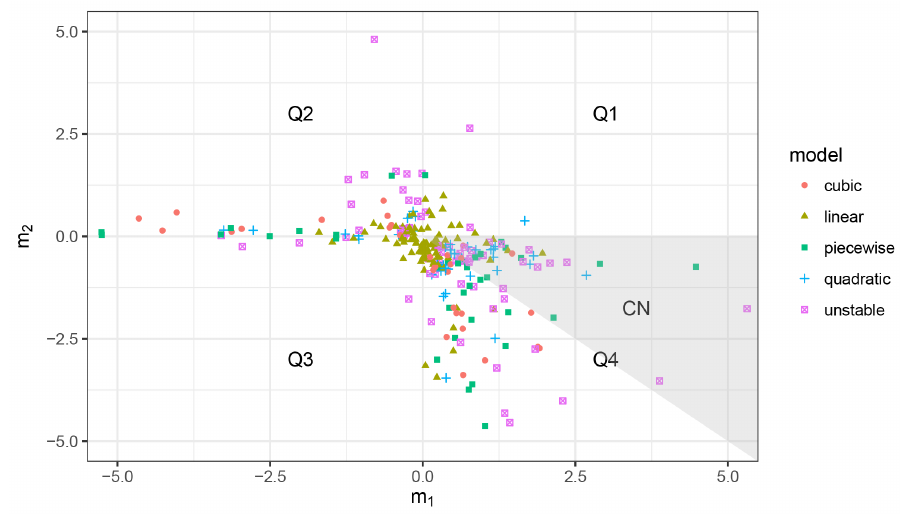
Figure 8 - Visualization of trajectories using coefficients of a piecewise linear function for career trajectories of senior researchers (288 trajectories). Each trajectory is marked by the best-fitting model according to BIC value. The piecewise-linear function had the smallest BIC for 58 (20.1%) trajectories. Only CN = 70 are within the octant corresponding to the conventional narrative, that 0 m > , 2 0 m < , and 1 2 m m > . Among the trajectories in CN , only 4.5% ( N= 13) are best-fit with is 1 piece-wise model. The number of trajectories in the quadrants are Q1 = 15, Q2 = 77, Q3 = 33, and Q4 =